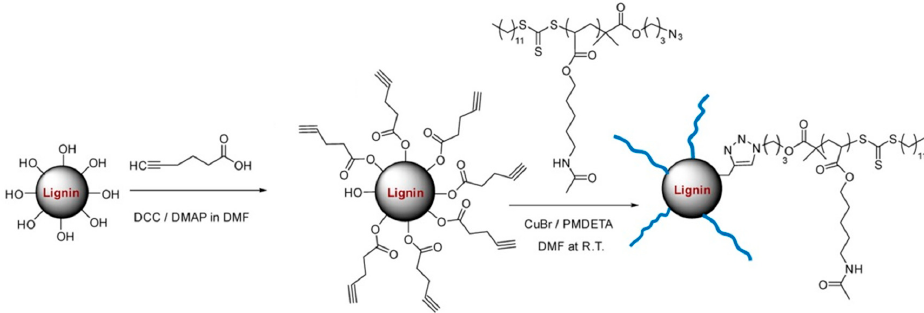
Figure 2. Modification and CuAAC click coupling of lignin in nanocomposite fabrication. Adapted with permission from [20]. Copyright © 2016 by the American Chemical Society.